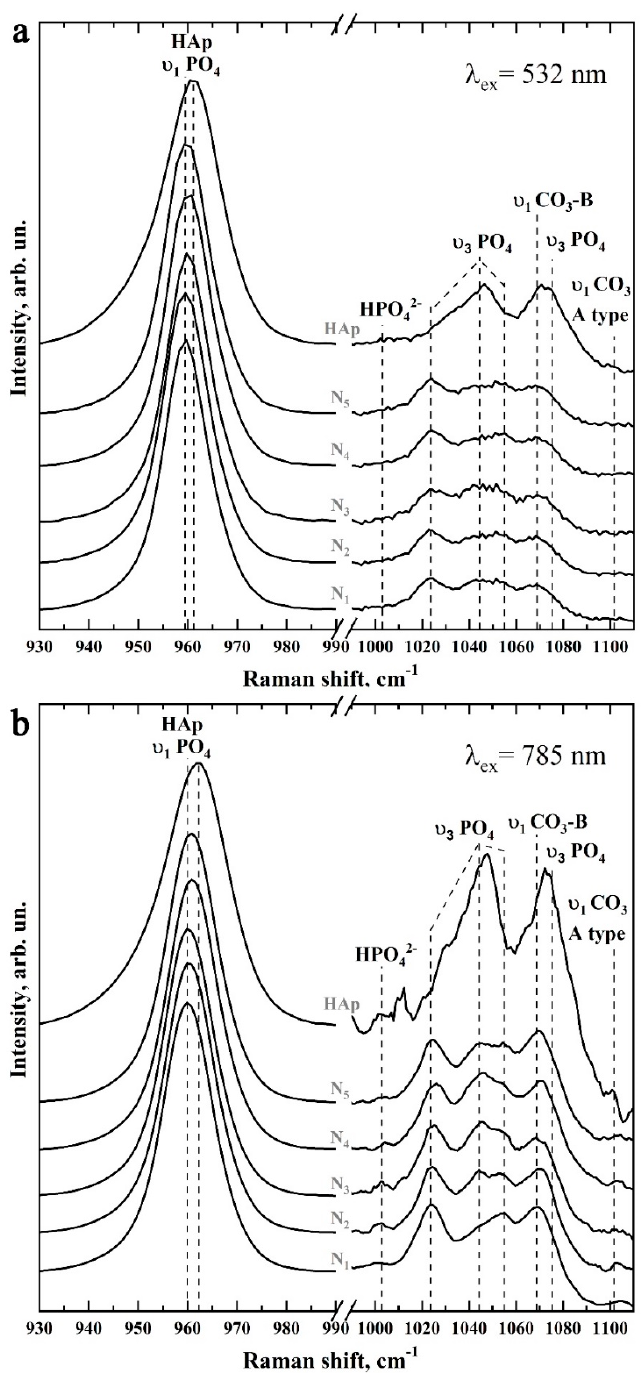
Figure 10. Raman spectra of samples N1–N5 and ncHAp in the regions 930–990 cm − 1 (left) and 990–1110 cm − 1 (right): ( a ) excitation using 532 nm laser radiation; ( b ) excitation using 785 nm laser radiation.